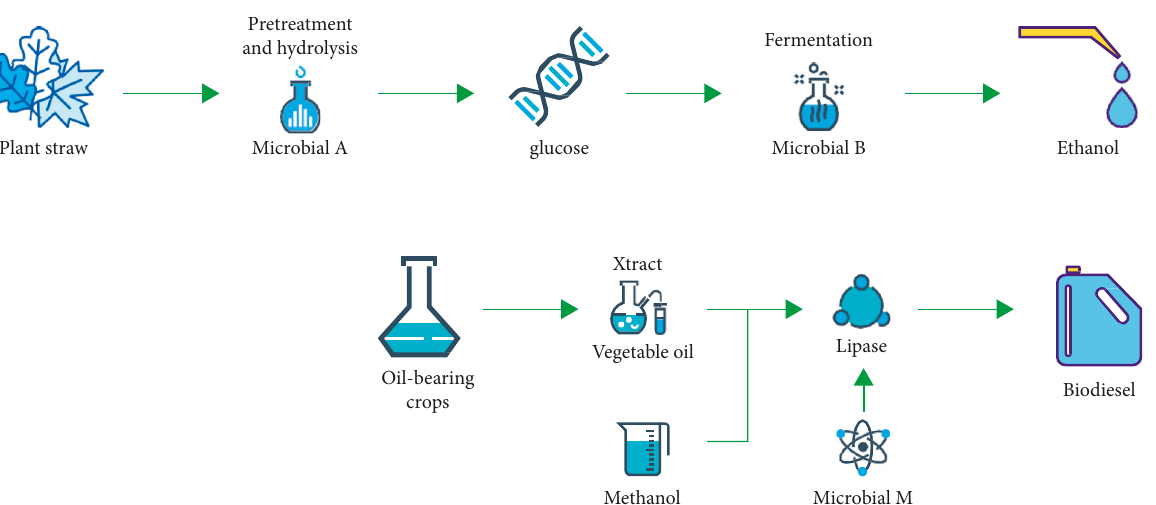
Figure 1: Atrazine, a special chemical weeding for